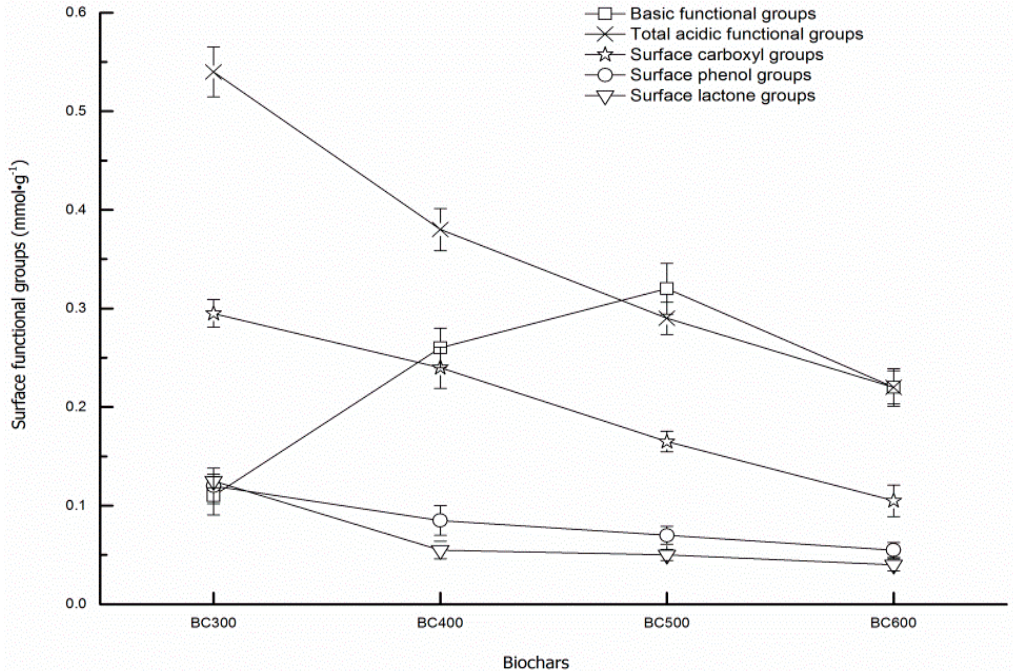
Figure 5. Variation in surface functional groups as a function of pyrolysis temperature. Individual points are averages ( n = 3) and error bars are standard deviations.